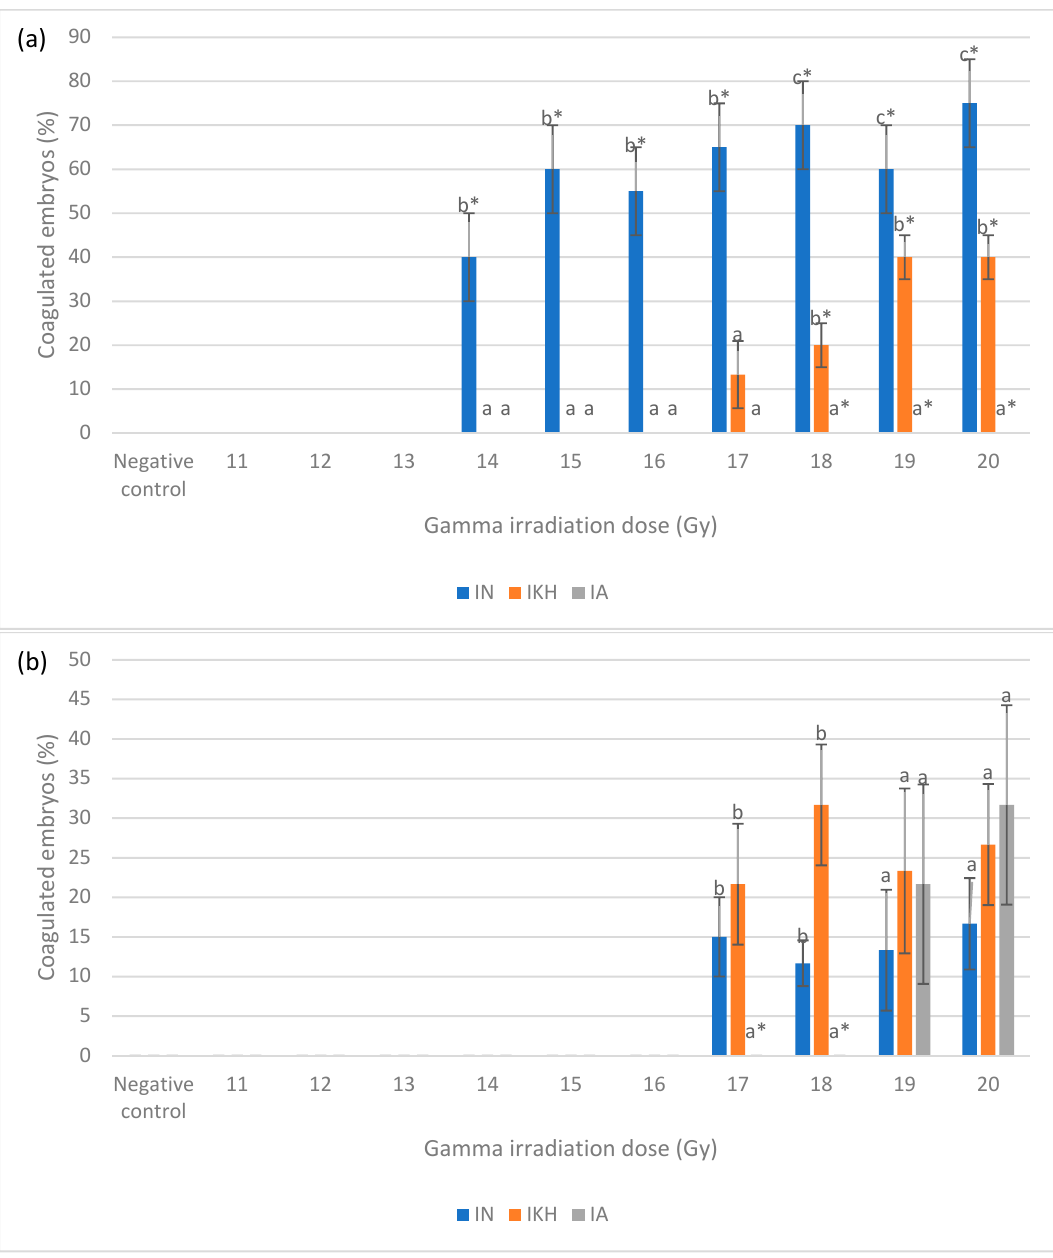
Figure 2. ( a ) Coagulated zebrafish embryos in IN, IKH and IA groups at 24 h post ‐ irradiation. ( b ) Coagulated zebrafish embryos in IN, IKH and IA groups at 48 h post ‐ irradiation. a*, b* and c* indicate significant difference ( p < 0.05) compared to other treatment groups. a and b indicate no significant difference ( p > 0.05) compared to other treatment groups. The total percentages of coagulated embryos from 24 h to 48 h post ‐ irradiation for each irradiation dose in IN, IKH and IA group are shown in Figure 3. The highest number of coagulated embryos were noted at 14 Gy to 20 Gy of irradiation dose in the IN group with percentages of 40% to 92%. Coagulation incidence in the IA group was significantly lower at 17 Gy, 18 Gy and 20 Gy of irradiation dose with percentages of 0% to 32%,